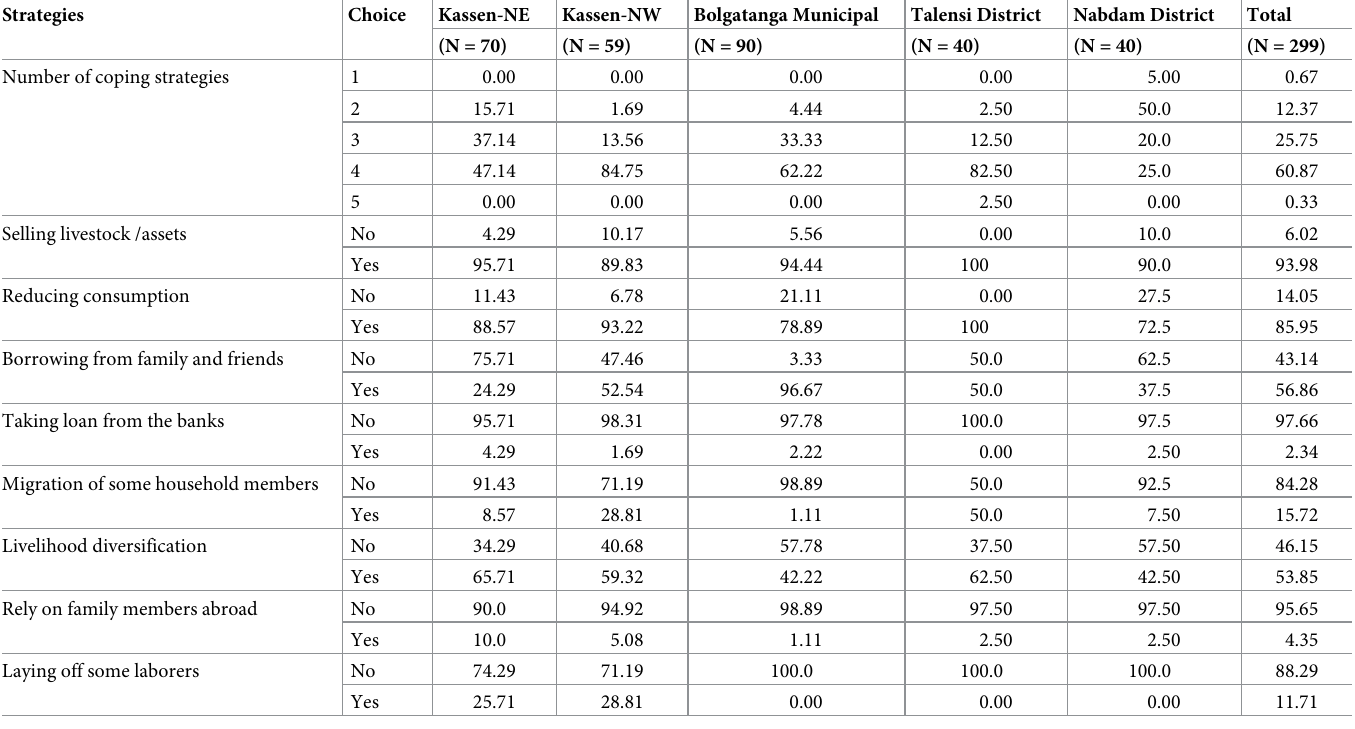
Table 2. District level comparison of choice and intensity of coping strategies.